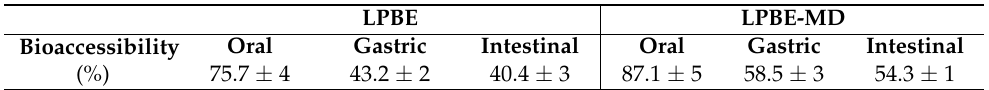
Table 3. Bioaccessibility (%) of non-encapsulated (LPBE) and encapsulated (LPBE-MD) PBE before and after gastrointestinal digestion.